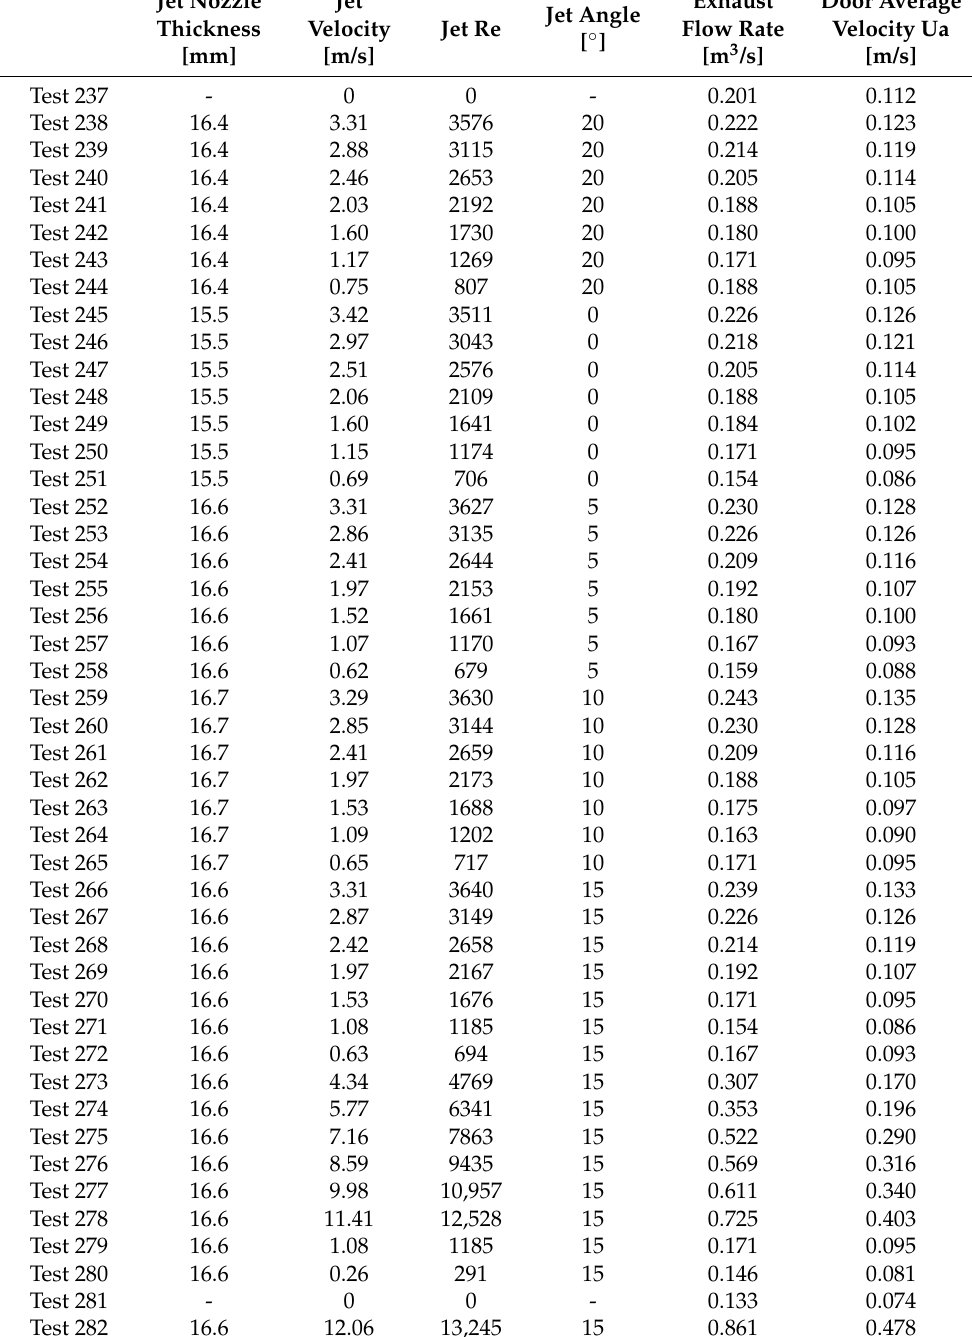
Table 3. Conditions of the tests for the 16 mm nominal thickness of the jet